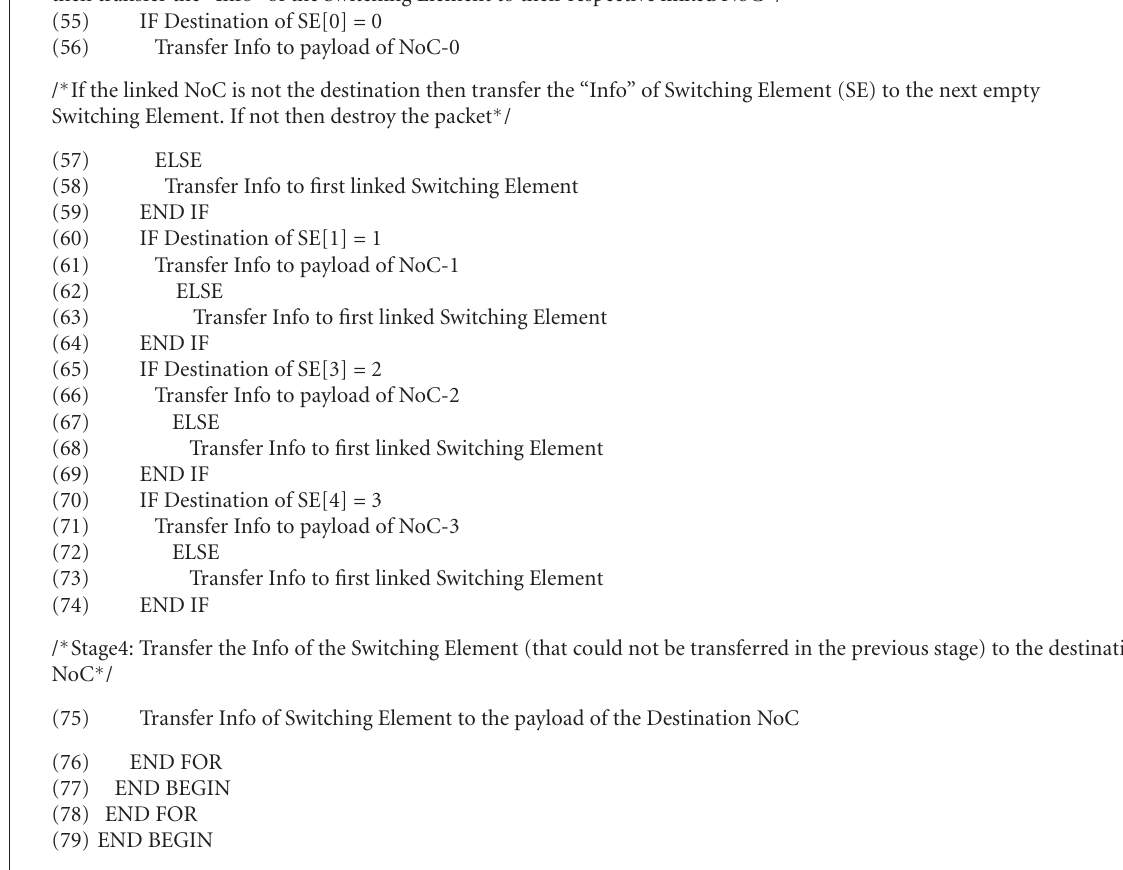
Algorithm 2: NoC PS IRREGULAR